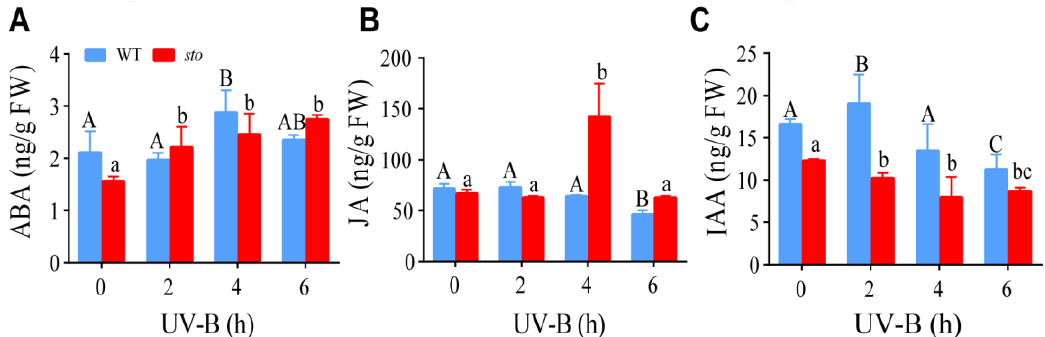
Figure 11. Changes of endogenous hormones ABA, JA, and IAA in wild-type and sto mutant under UV-B radiation. The seedlings of WT and sto were treated with UV-B (0.6W / m 2 ) for 2, 4, and 6 h, respectively. The seedlings in the soil grew under white light for 12 d, then irradiated with UV-B (0.6 W/m 2 ). Error bars indicate the SEM of three independent biological and technical replicates. Different capital letters and lowercase letters indicate significant differences between changes of endogenous hormones of those seedlings grown without or with UV-B radiation, respectively ( P < 0.05, Dunnett’s multiple).